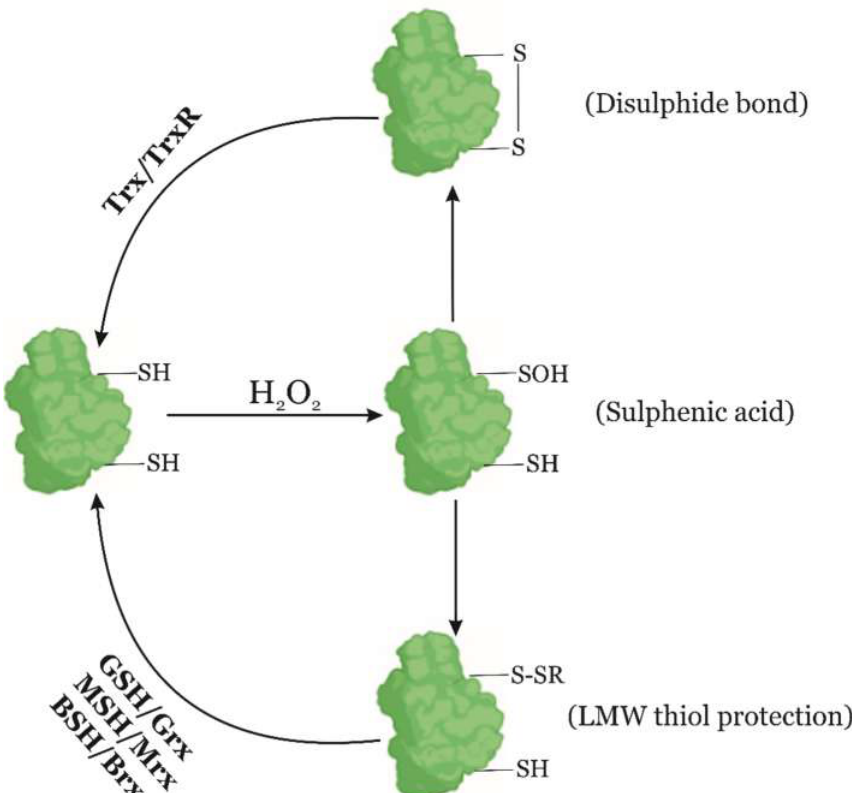
Figure 2. Bacterial redox mechanisms. When a cysteine of a target protein (in green) is oxidized by RONS its thiol group is converted to sulfenic acid (-SOH). To prevent overoxidation, the sulfenic acid is reduced by other thiol groups of the protein generating a disulphide bond, or by low molecular weight-thiols (LMW-thiols; S-SR). Eventually, thioredoxins (Trx) reduce the oxidized cysteine residues and break the disulphide bond, whereas LMW-thiols are reduced back by glutaredoxins (Grx), mycoredoxins (Mrx), or bacilliredoxins (Brx).